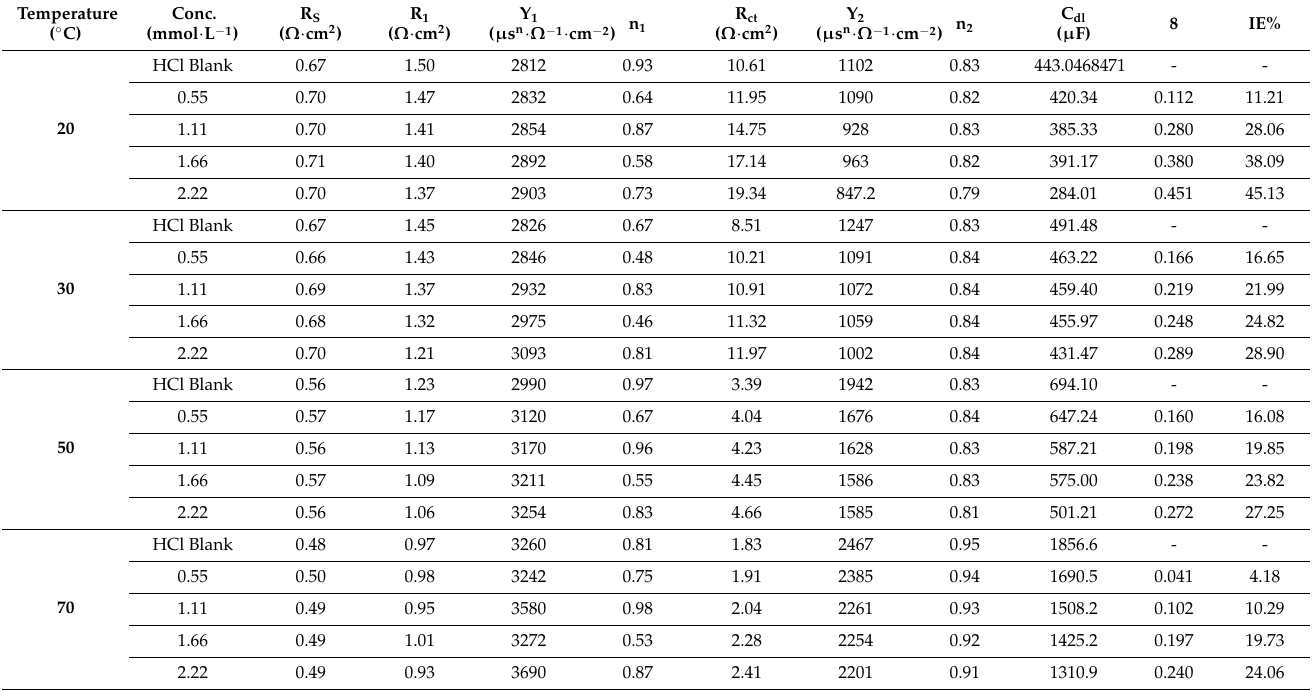
Table 2. EIS parameters and corrosion inhibition efficiencies of impedance spectra of C-steel in differ- ent concentrations of Q-22 at 20, 30, 50, and 70 ◦ C according to the equivalent electric circuit fitting. Temperature ( ◦